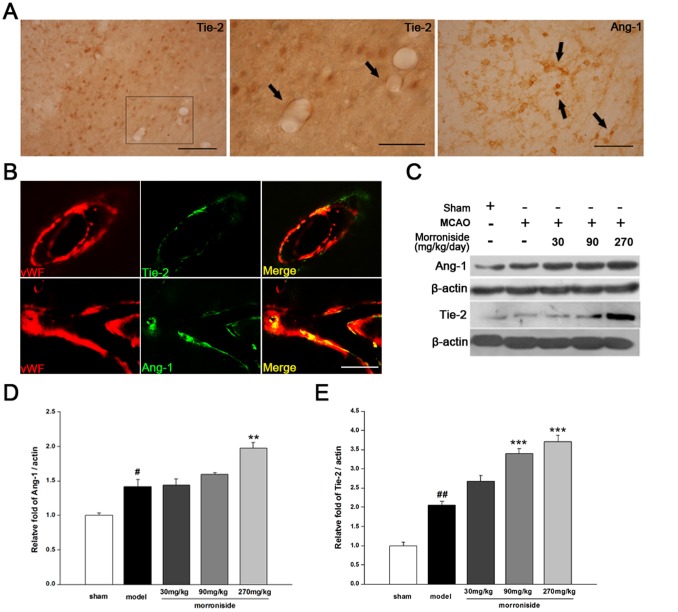
Effects of morroniside on the expression of Ang-1 and its receptor Tie-2 in the peri-infarct cortex of rats 7 days after cerebral ischemia.(A) Immunohistochemical staining of vessel-associated Tie-2 in the peri-infarct region (arrows), and new vessels with incomplete Ang-1-positive endothelial-like cell lining 7 days after ischemic/reperfusion treatment. Scale bar, 100 µm, and 50 µm for the enlarged image of Tie-2. (B) Double immunofluorecence staining of vWF with Ang-1 and Tie-2 indicated Ang-1 and Tie-2 were localized in endothelial cells. Scale bar, 50 µm. (C) Protein expression of Ang-1 (60 kDa) and Tie-2 (140 kDa) in the ipsilateral cortex 7 days after MCAO by immunoblotting. Quantitative analysis of Ang-1 and Tie-2 is expressed as a fraction of the respective levels of β-actin. n = 3 for each group. The values are the mean ± SEM. #
p<0.05 and ##
p<0.01 versus sham-operated control group; **p<0.01 and ***p<0.001 versus vehicle-treated ischemic group.